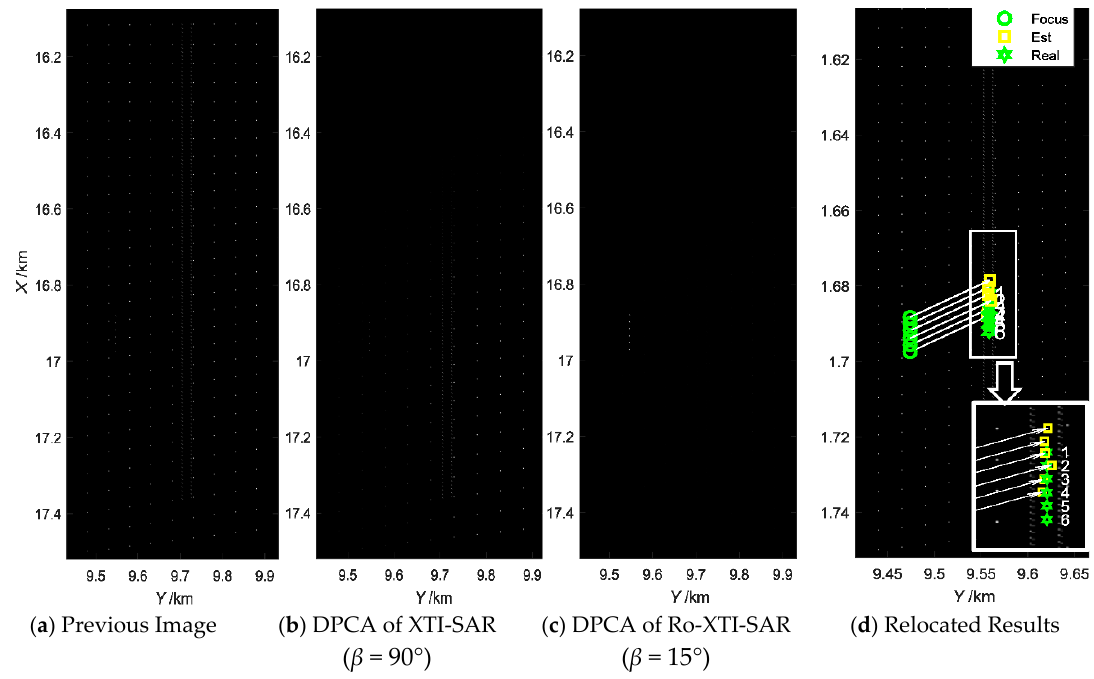
Figure 8. GMTI results of three-channel airborne Ro-XTI-SAR system. ( a ) is the previous SAR image; ( b ) is the image after DPCA of a traditional XTI-SAR with the baseline angle 90°; ( c ) is the image after DPCA of the proposed Ro-XTI-SAR system; ( d ) is the detection and relocation results of the moving targets.